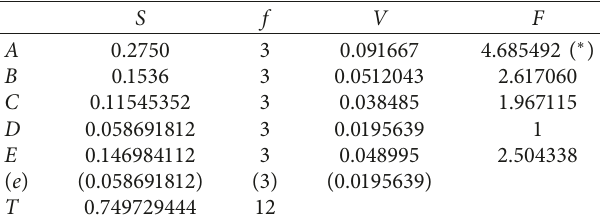
Table 15: Variance analysis table.